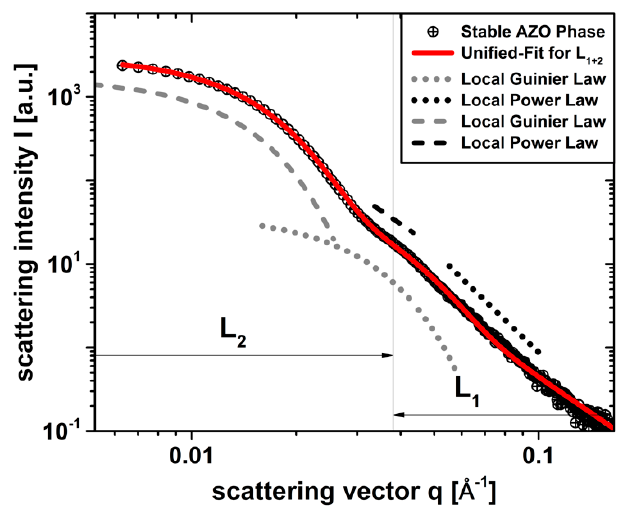
Figure 4. SAXS curve of the stable AZO phase in ethanol from the initial AZO dispersion in Figure 1 (black dots) after centrifugation and including the local Guinier- and Power-laws of two structural levels L 1 (dotted), L 2 (dashed). L 1 and L 2 were approximated using the Unified-Fit model according to Beaucage (solid line).